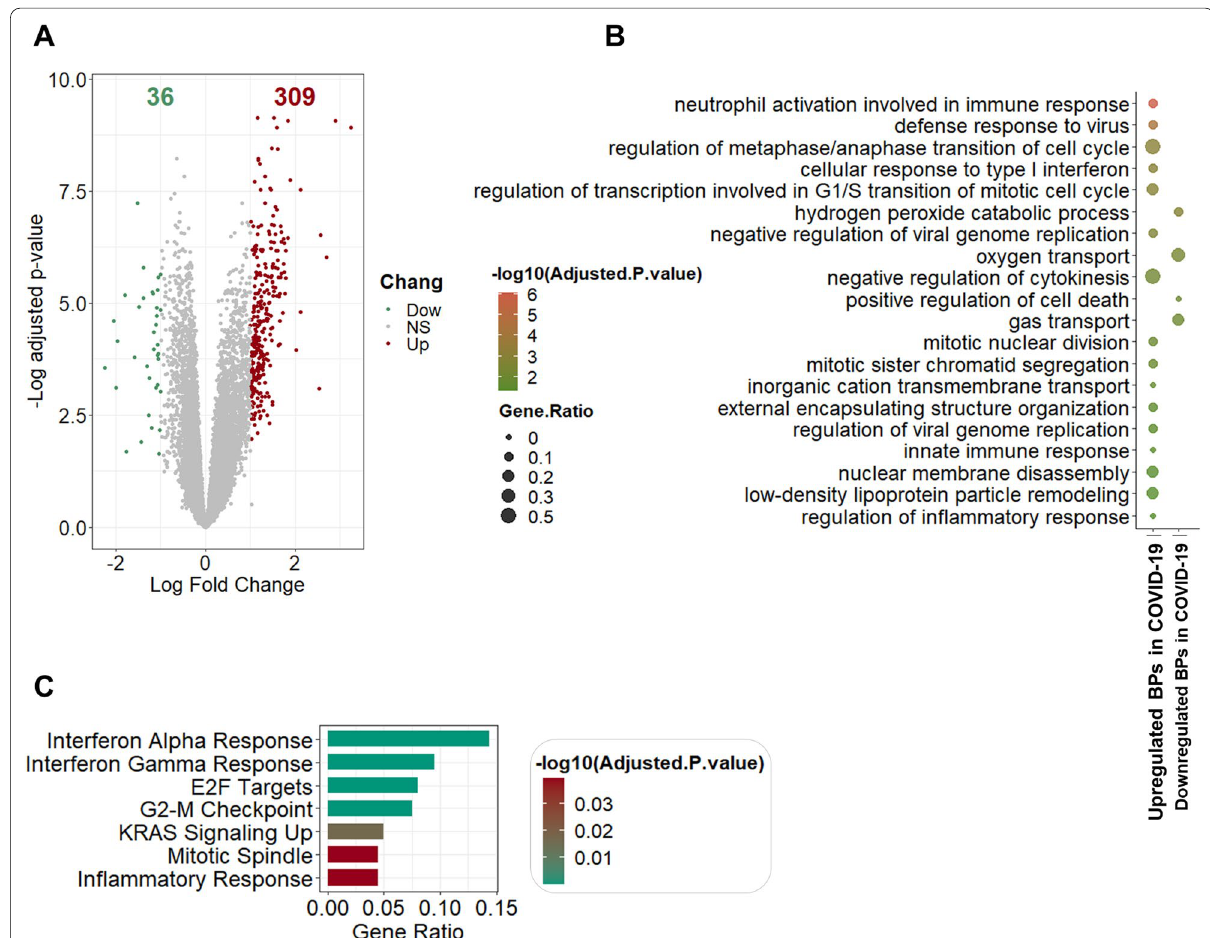
Fig. 2 Transcriptome analysis of whole blood samples of COVID-19 patients versus healthy controls: The volcano plot to demonstrate differential expressed genes which had adjusted P -value < 0.05, |Log 2 FC|> 1. Red and green show up and downregulated genes, respectively ( A ). Dot plot to show BPs (GO) according to significantly upregulated and downregulated genes. The size of the dots is proportional to the gene ratio in considering process and the color corresponds to the –log10 of the adjusted P -value. Selected top and not-redundant terms are visualized ( B ). Bar plot to depict hallmark gene set enrichment analysis. The size of the bars is proportional to the gene ratio in considering pathway and the color corresponds to the –log10 of the adjusted P-value ( C ). BP biological process, GO gene